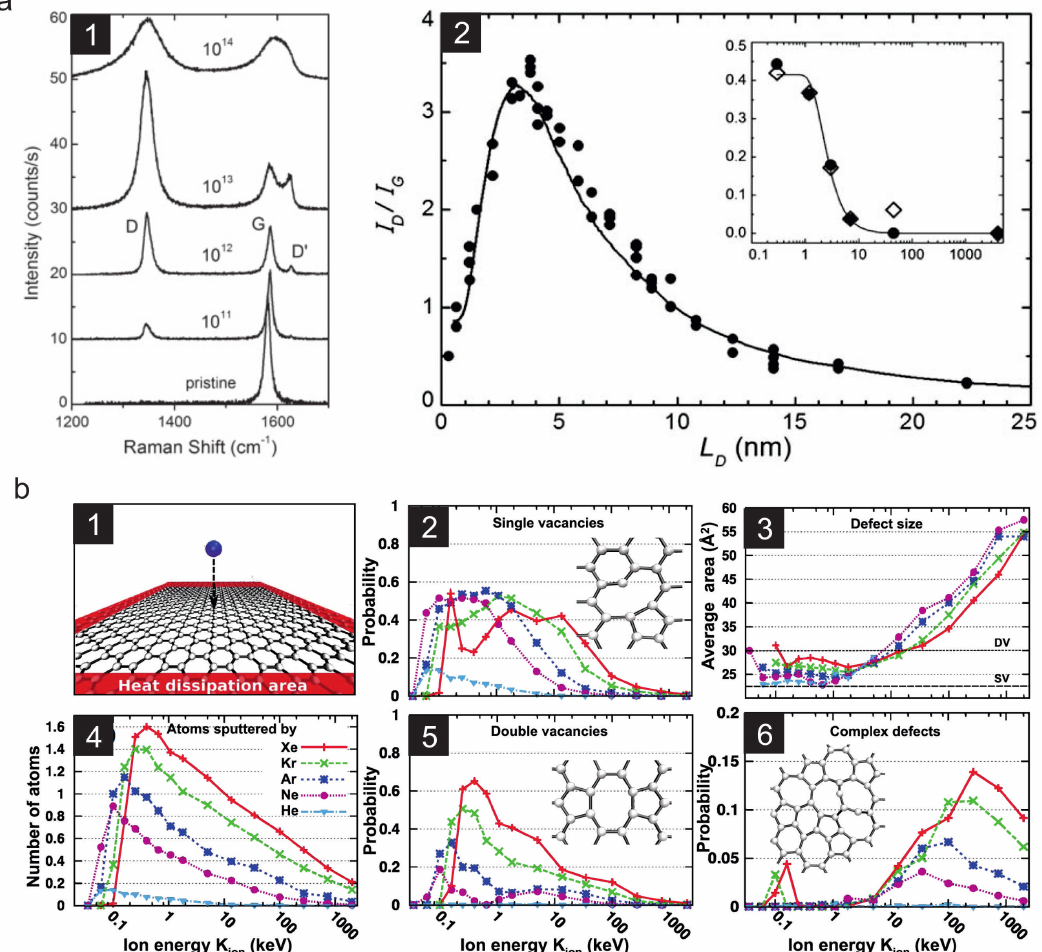
Figure 6. Defect creation in graphene by low energy ion irradiation. ( a1 ) Evolution of the Raman spectra of graphene with increasing ion fluence in units of ions/cm 2 (Ar + with E Kin = 90 eV). ( a2 ) The intensity ratio of the D and G peak I D / I G as a function of fluence (here given in terms of the mean distance L D between two impacts) shows a clear maximum at the point where the structurally disordered regions begin to dominate. This behavior is in contrast to graphite, as shown in the inset in ( a2 ). Reprinted from Ref. [71]. Copyright (2010), with permission from Elsevier. ( b ) Results of MD simulations of graphene evolution under noble gas ion irradiation. A significant probability to produce single ( b2 ) or double vacancies ( b5 ) in graphene is achieved at kinetic energies of (0.1–30) keV, where the nuclear stopping is at its maximum, compare with Figure 1a. More complex defects ( b6 ) are rarely produced and only at higher energies. Reprinted with permission from Ref. [72], copyright (2010) by the American Physical